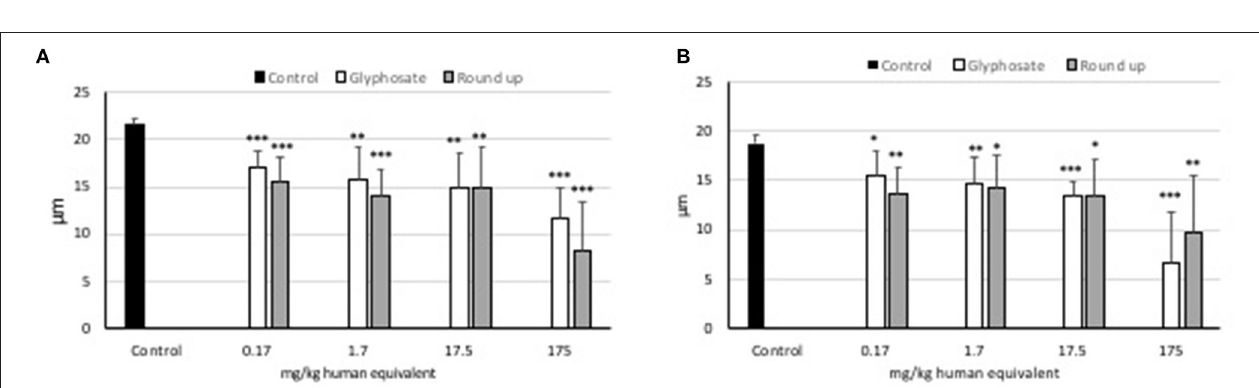
FIGURE 4 | Effects of pure glyphosate and Roundup Bioflow at the dose range 0–175mg kg − 1 (human equivalent) on cell size of L929 fibroblasts (A) and Caco2 cells (B) . Data are expressed as mean value ( ± st. dev.). Pairwise comparison based on Anova (Dunnett test). ns, not significant: * P < 0.05; ** P < 0.01; *** P < 0.001.